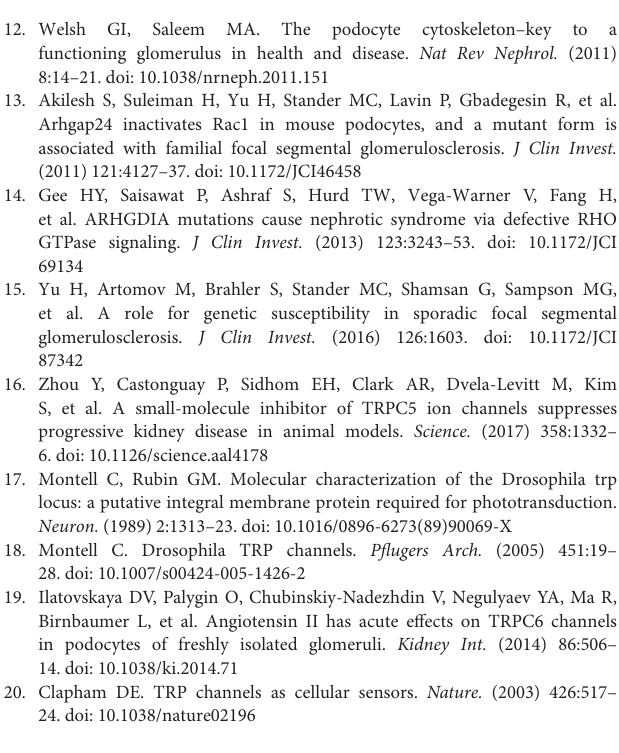
Supplementary Figure 1 | Inhibition of TRPC5 channel activity protects podocytes in PAN rats. (A) Representative immunostaining images of podocyte cytoskeletal and marker proteins podocin, synaptopodin, and WT1 from PBS, PAN and PAN + AC1903 treated rats on day 7. Scale bar 20 µ m. Supplementary Figure 2 | Expression levels of SYNPO , NPHS1 , NPHS2 , and WT1 in human iPSC-derived podocytes. (A–D) qPCR results of podocyte markers SYNPO (A) , NPHS1 (B) , NPHS2 (C) , and WT1 (D) from hiPSC and iPodo. hiPSC n = 3, iPodo n = 3. ∗∗ p < 0.01 vs. hiPSC. Supplementary Figure 3 | Bright-field images of human iPSCs and kidney organoids. (A) Bright-field images of human iPSCs ( A , scale bar 200 µ m), kidney organoid at day 6 (B) , day 15 (C) , and day 25 (D) . Scale bars (B–D) 50 µ m. Supplementary Figure 4 | Inhibition of TRPC5 activity protects podocin and synaptopodin in human kidney organoids treated with PAN. (A,B) Immunostaining for podocin (A) and synaptopodin (B) in PBS, PAN and PAN + AC1903 treated kidney organoids. Scale bar 20 µ